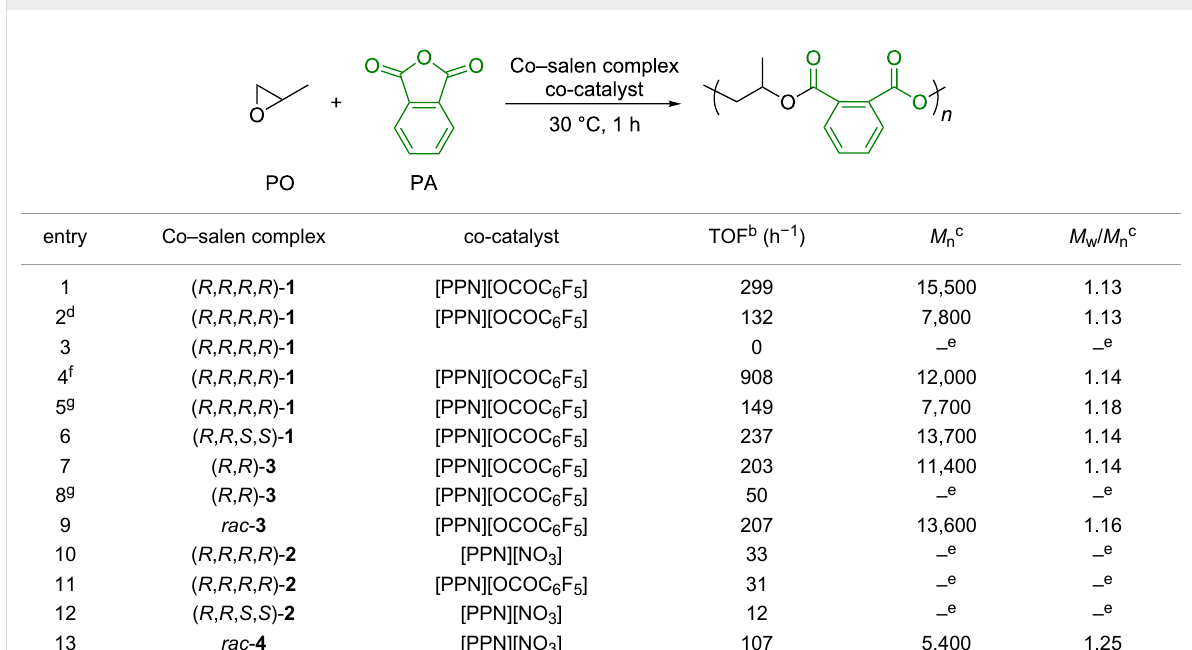
Table 1: Copolymerization of propylene oxide (PO) with phthalic anhydride (PA) using cobalt–salen complexes.